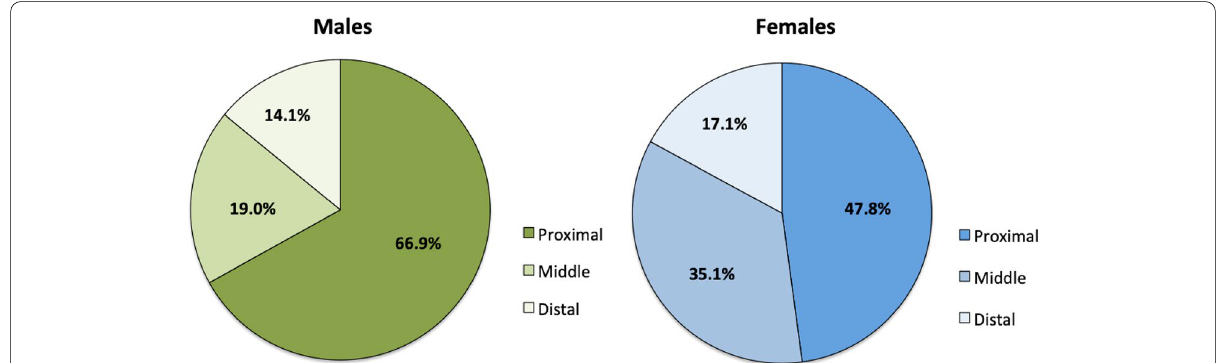
Fig. 4 Comparison of regional ACL perfusion between genders revealed differences between males and